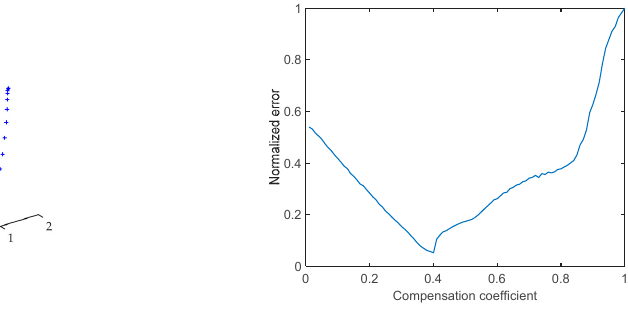
Figure 8. Parameter estimation method under case 2.